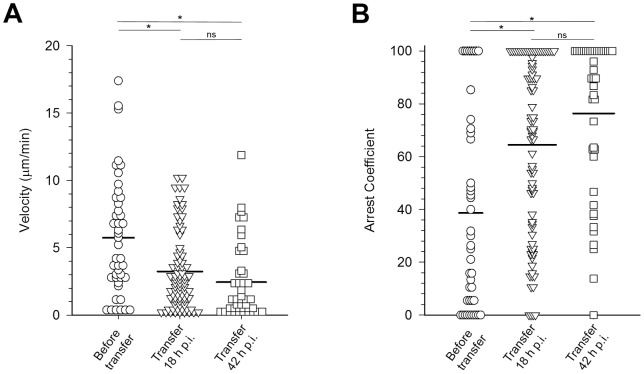
Tracking adoptively transferred Py-RAS activated CD8+ T cells in the livers of infected mice.LS were identified in a well-immobilized area of the liver and labeled CD8+ T cells in the vicinity of the LS were monitored to calculated velocities (A) and arrest coefficients (B). Py-RAS CD8+ T cells in the liver of immunized mice (circles) were used as controls. CD8+ T cells were purified 2 weeks after the second booster from the spleens of Py-RAS immunized mice and 1 million was adoptively transferred into recipient mice 18 h (triangles) or 42 h (squares) after infection with PyXNL-GFP. Based on ANOVA on Ranks, the velocity and arrest coefficients of all adoptively transferred cells differed significantly from Py-RAS in the liver of immunized mice (p<0.05). The same test showed only a significant difference in the values between the two 18 h time points. At least nine infected mice were used per experimental condition. *  =  p<0.05, ns  =  not significant.